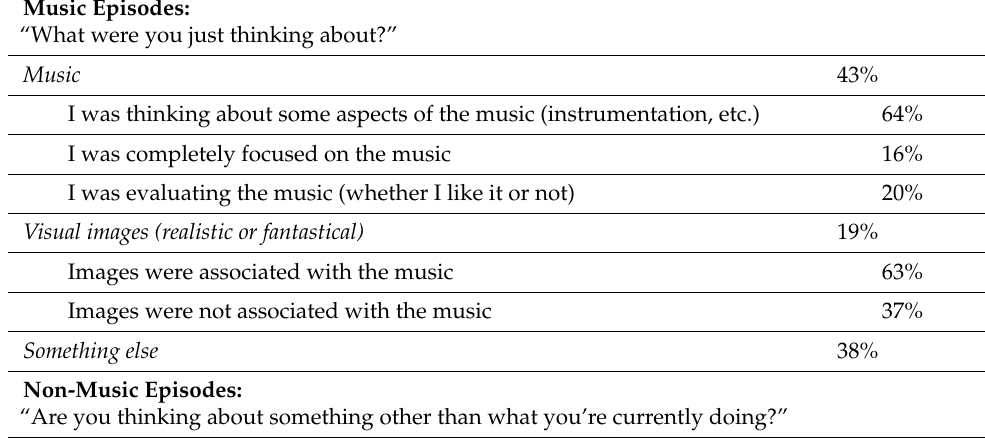
Table 2. Breakdown of the focus of attention during music and non-music episodes. Music